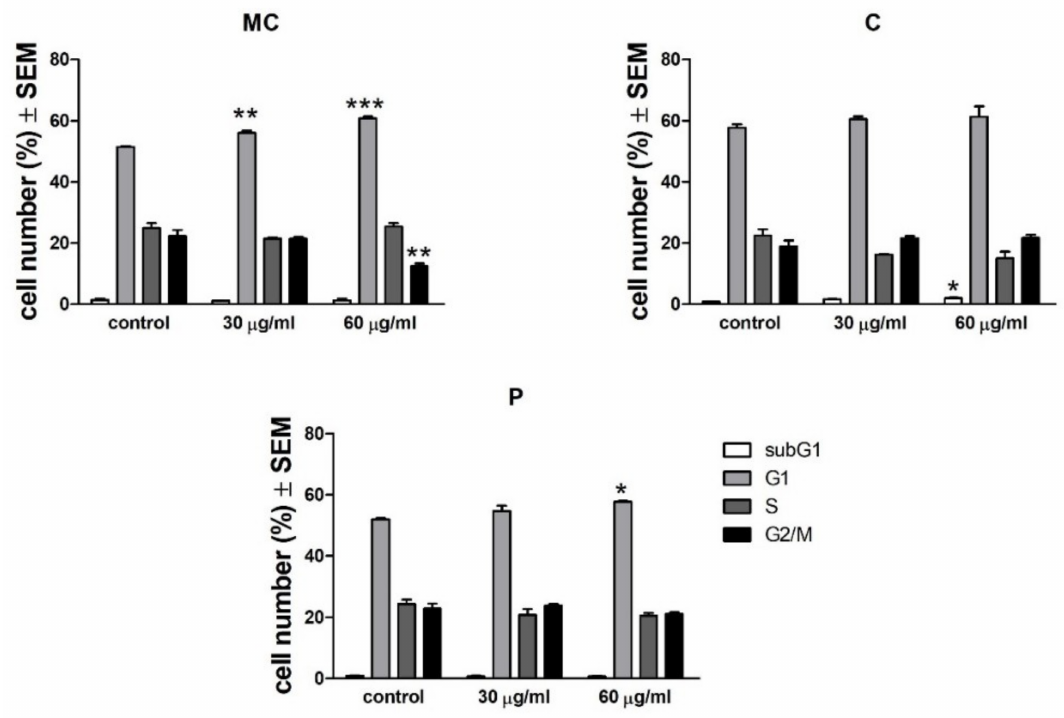
Figure 3. Effect of MC, C, and P extracts on cell cycle phases for A375 melanoma cell line. Statistical significance was assessed by one-way ANOVA with Newman–Keuls post-test for comparison of multiple groups *, ** and *** indicate p < 0.05, p < 0.01 and p < 0.001, respectively, compared to the control